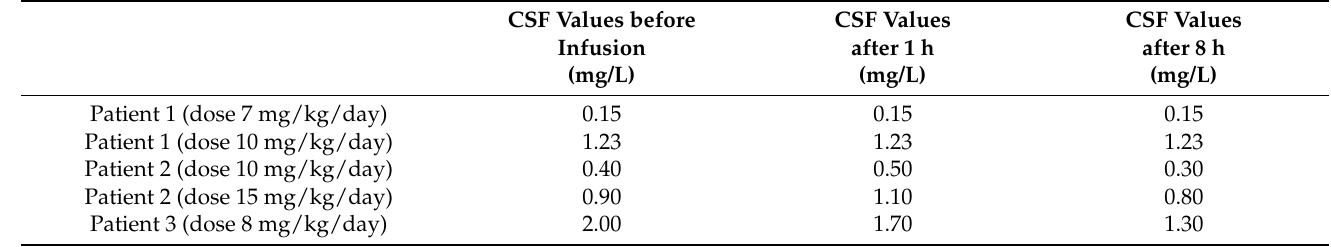
Table 3. CSF micafungin concentrations in three patients before and after different dose infusions.